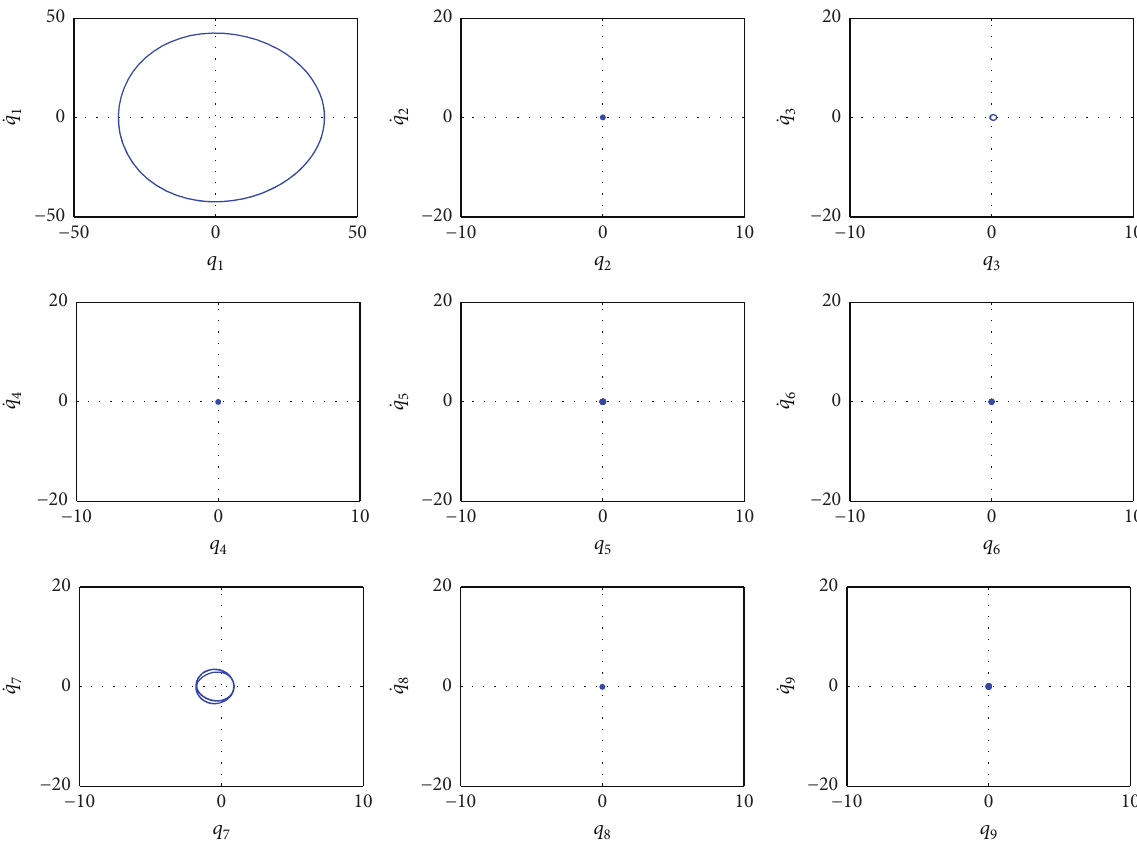
When the initial dynamic configuration of the cable-stayed bridge corresponds to one of its higher mode shapes, chaotic response occurs even if its amplitude is relatively small; this is shown in Figure 19 where the initial dynamic configuration of the cable-stayed bridge corresponds to its second mode shape and its magnitude is only